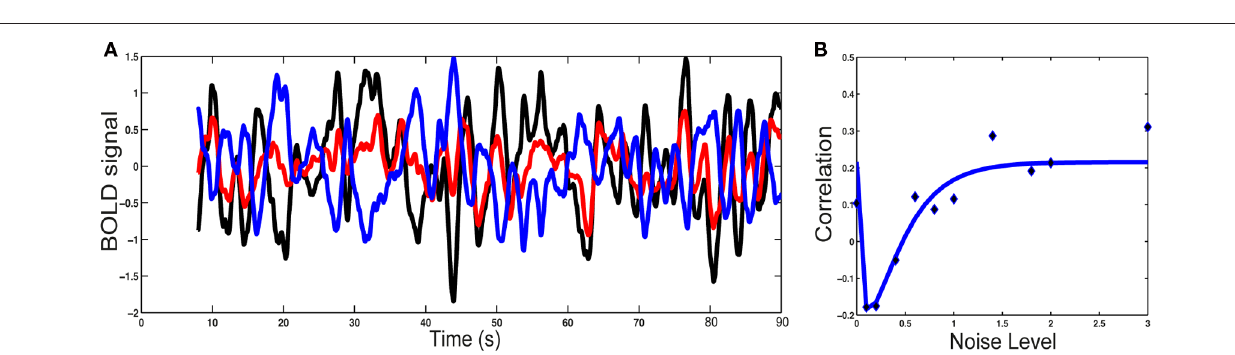
Figure 2 | Blood oxygen level-dependent signal analysis. (A) BOLD fluctuations for each community (1: black; 2: red) and for the difference (blue). (B) Correlation between the synchronization level of the two communities versus the